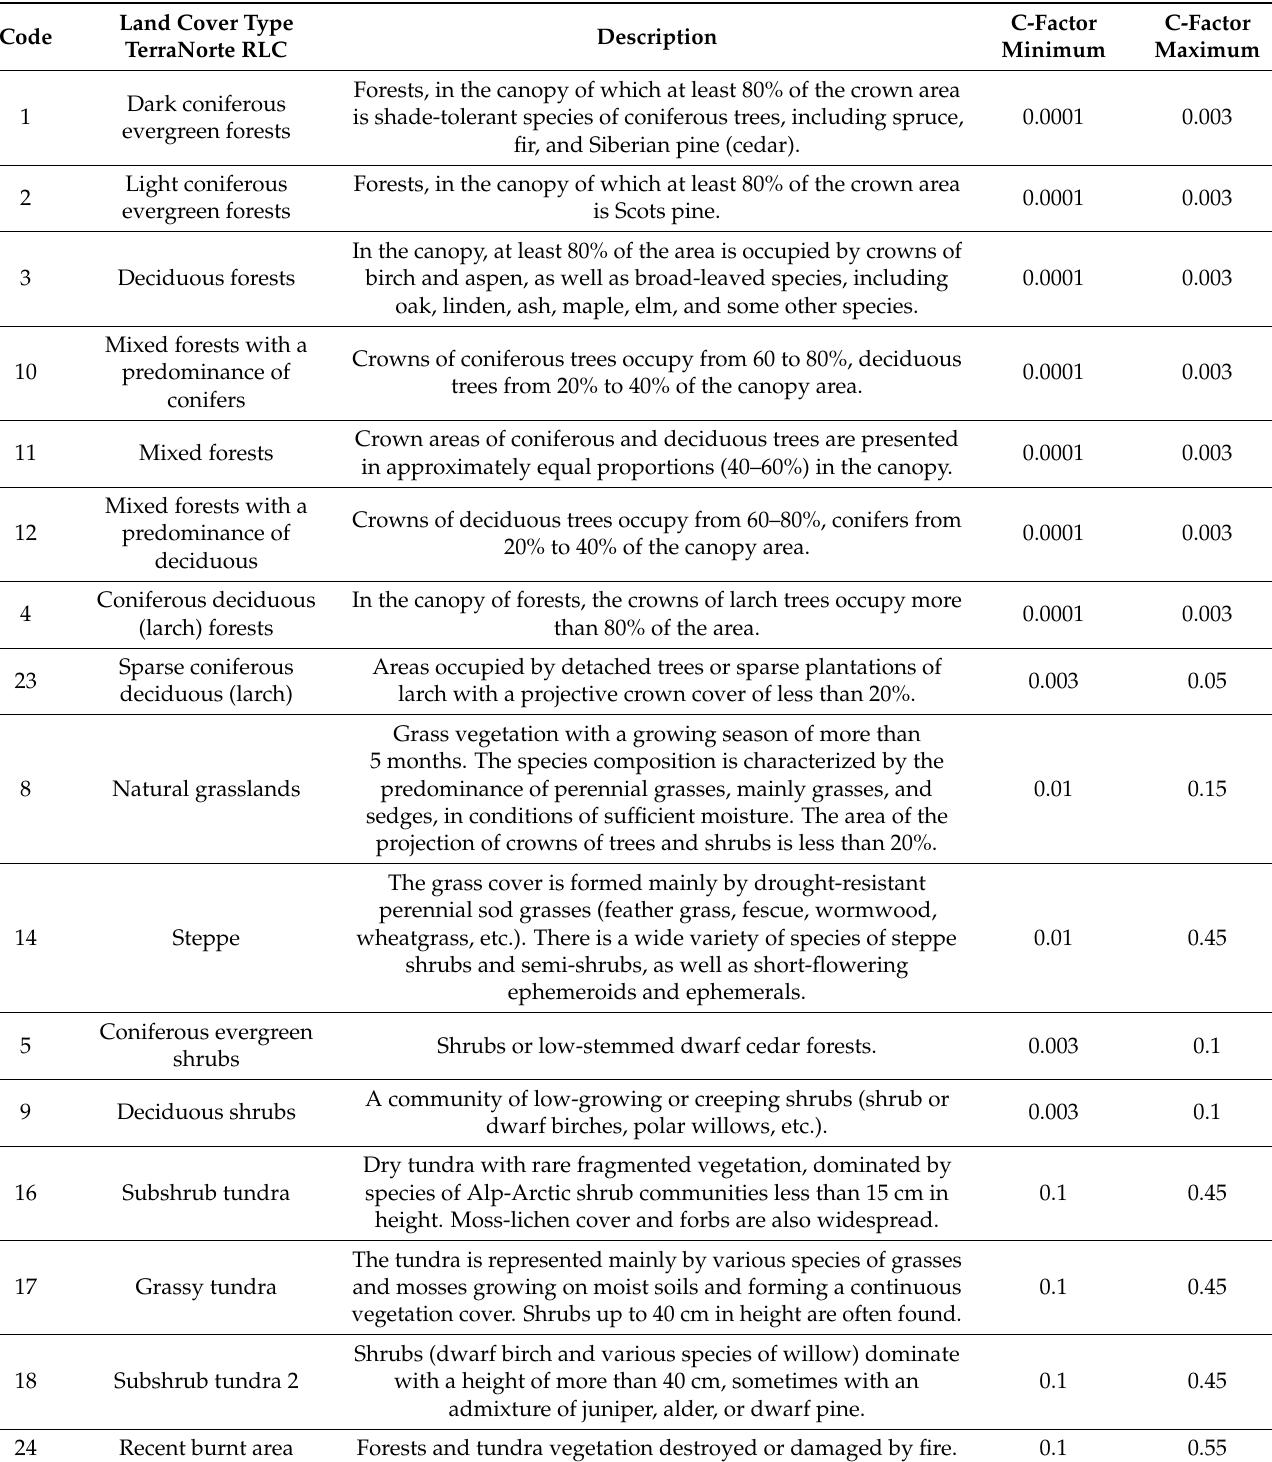
Table 5. C-factor for types of non-arable land cover according to literature